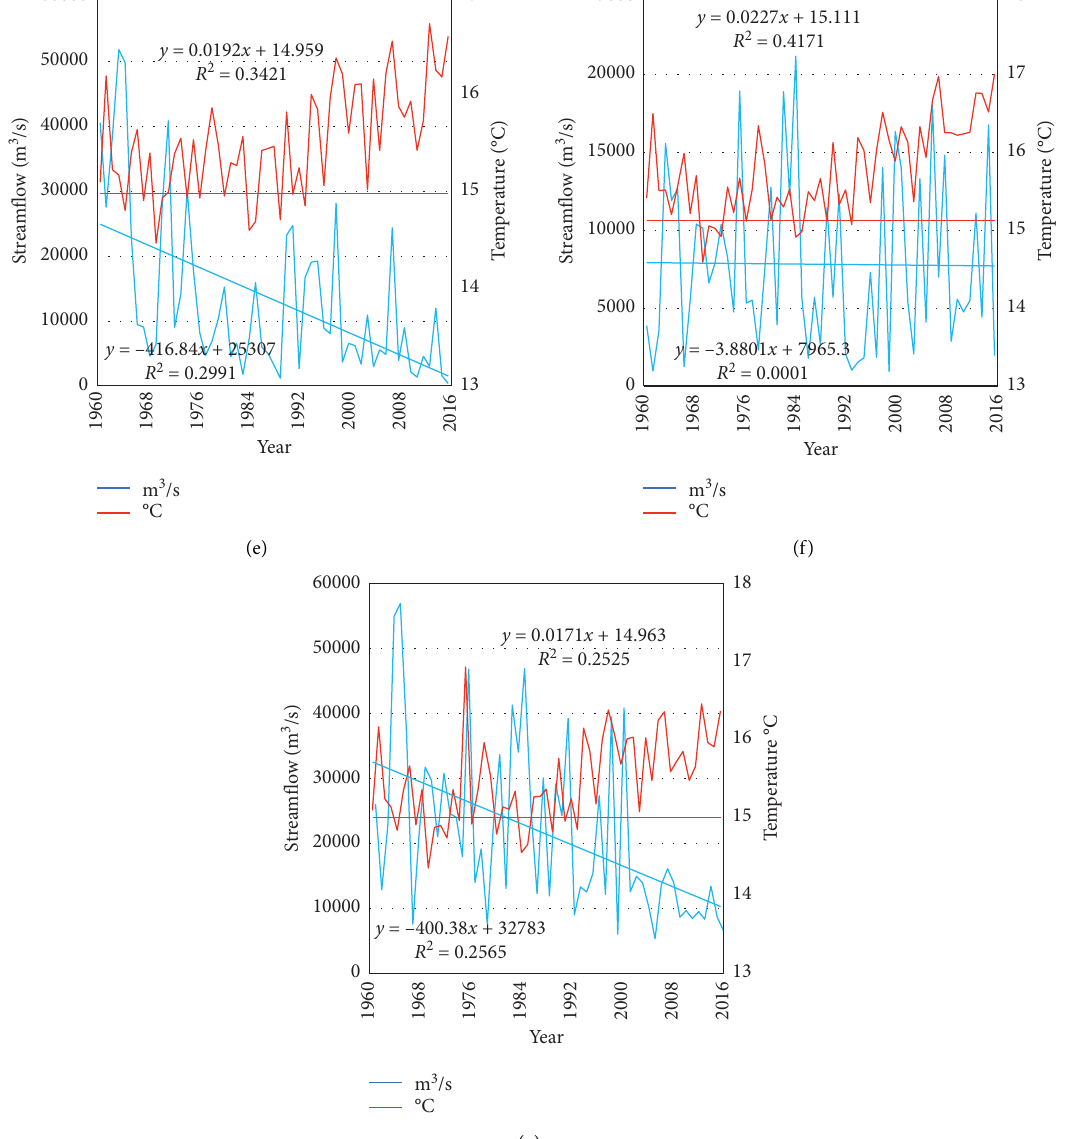
Figure 7: Long-term relation between temperature and streamflow variation, in the course of 1960–2016. (a) Xiangcheng. (b) Zhumadian. (c) Gushi. (d) Fuyang. (e) Xinyang. (f) Xichong. (g) Average